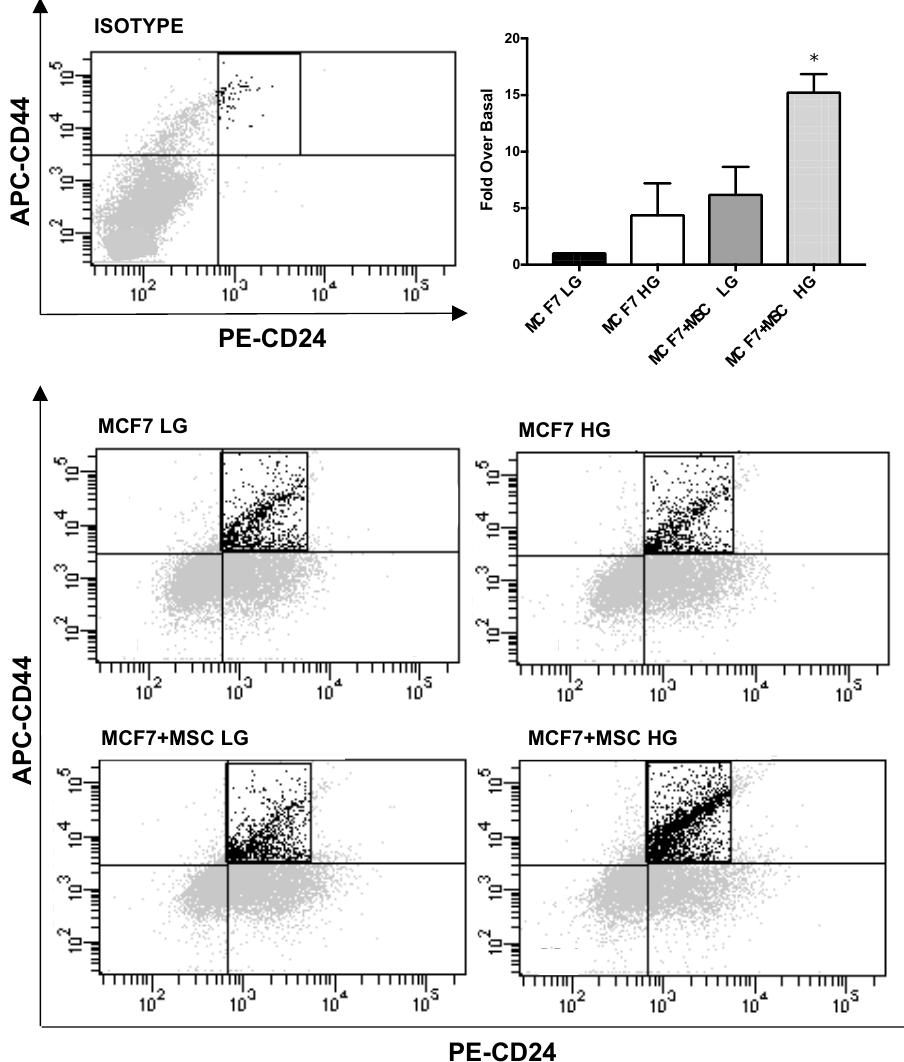
Figure 5. Quantification of CD44 high /CD24 low subpopulation in BC cells co-cultured with MAT-MSCs. MCF7 were co-cultured—and not—with MAT-MSCs in LG or HG medium. After 72 h, CD44 high /CD24 low stem cell subpopulation was identified in monocultured (MCF7 LG/HG) and co-cultured (MCF7 + MSC LG/HG) MCF7 by FACS analysis (See Section 2). Representative dot plots show MCF7 stained with APC-anti-CD44 and PE-anti-CD24 as well as dye/isotype matched antibodies. In the graph, the percentage of population was reported as fold over basal (MCF7 LG) and showed CD44 high /CD24 low cell subpopulation as mean ± SD of 4 independent experiments. Data were analyzed using the non-parametric Friedman test followed by Dunn’s correction for multiple comparisons. * denotes statistically significant values compared with MCF7 LG (* adjp < 0.01).